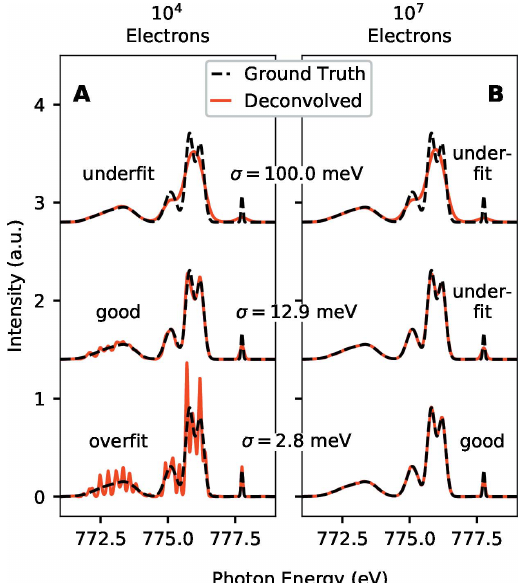
Figure 3 Effect of regularization strength on deconvolved PAX spectra. (Spectra with different regularization strengths are vertically offset for clarity.) (A) Ground truth and deconvolved spectra for different regularization strengths and 10 4 simulated detected electrons. (B) Same as part A, except for 10 7 simulated detected